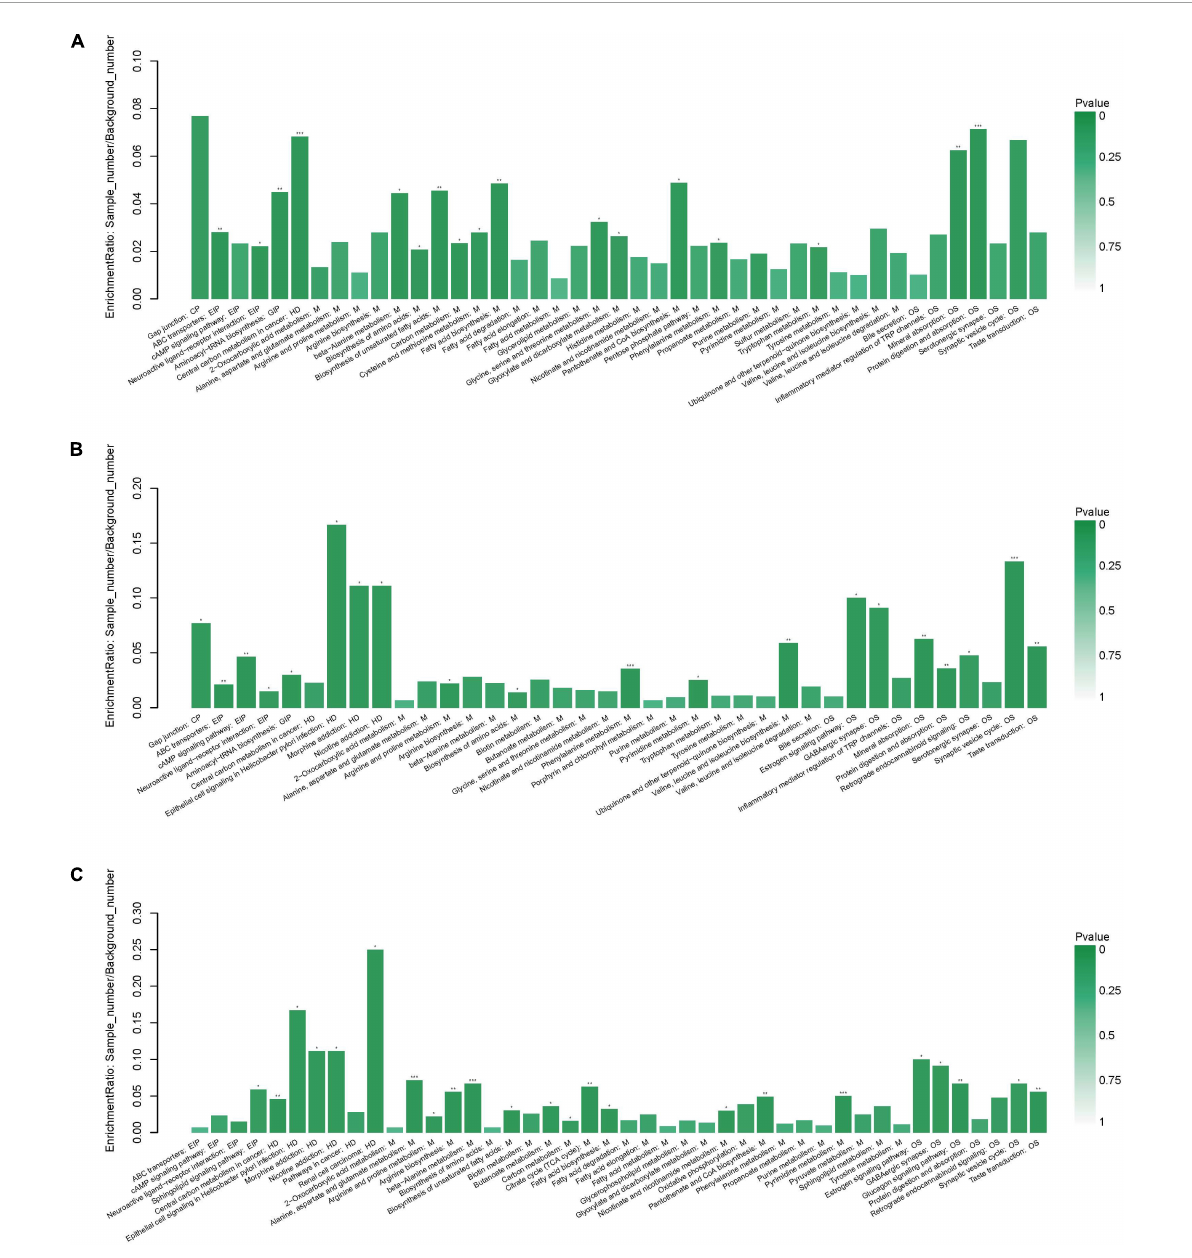
FIGURE8 Functional enrichment analysis of differential metabolites between groups. Pathway analysis of salivary metabolites with significant difference between AgP and PH (A) , between ChP and PH (B) , and between AgP and ChP (C) . The height of the column represents the enrichment rate. * p < 0.05, ** p < 0.01, *** p <